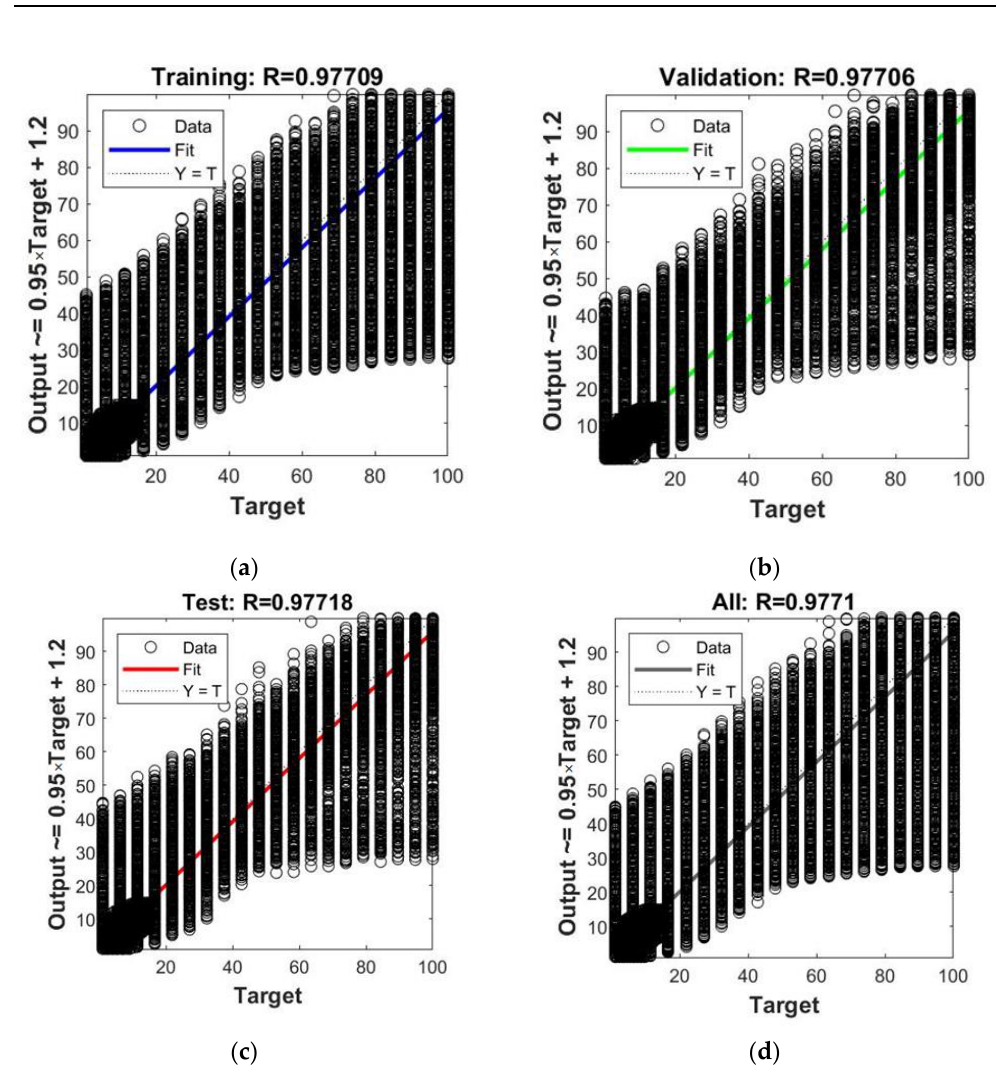
Figure 5. Regression charts for model with 12 hidden neurons: ( a ) Training sample; ( b ) Validation sample; ( c ) Test sample; ( d ) Full sample